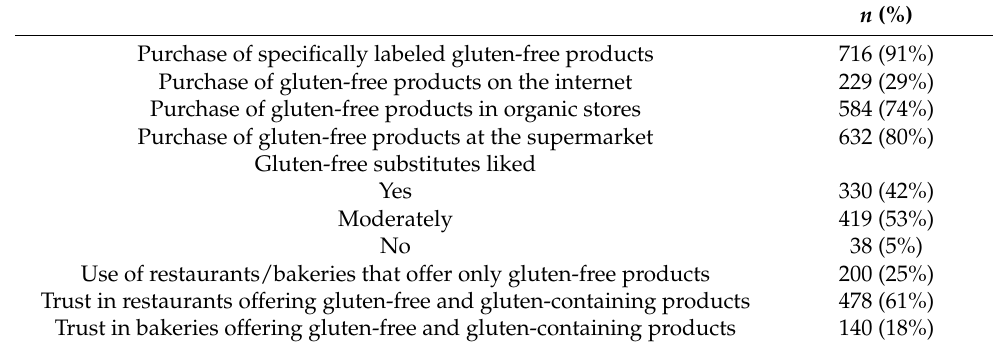
Table 2. Purchasing and consumption habits of gluten-free